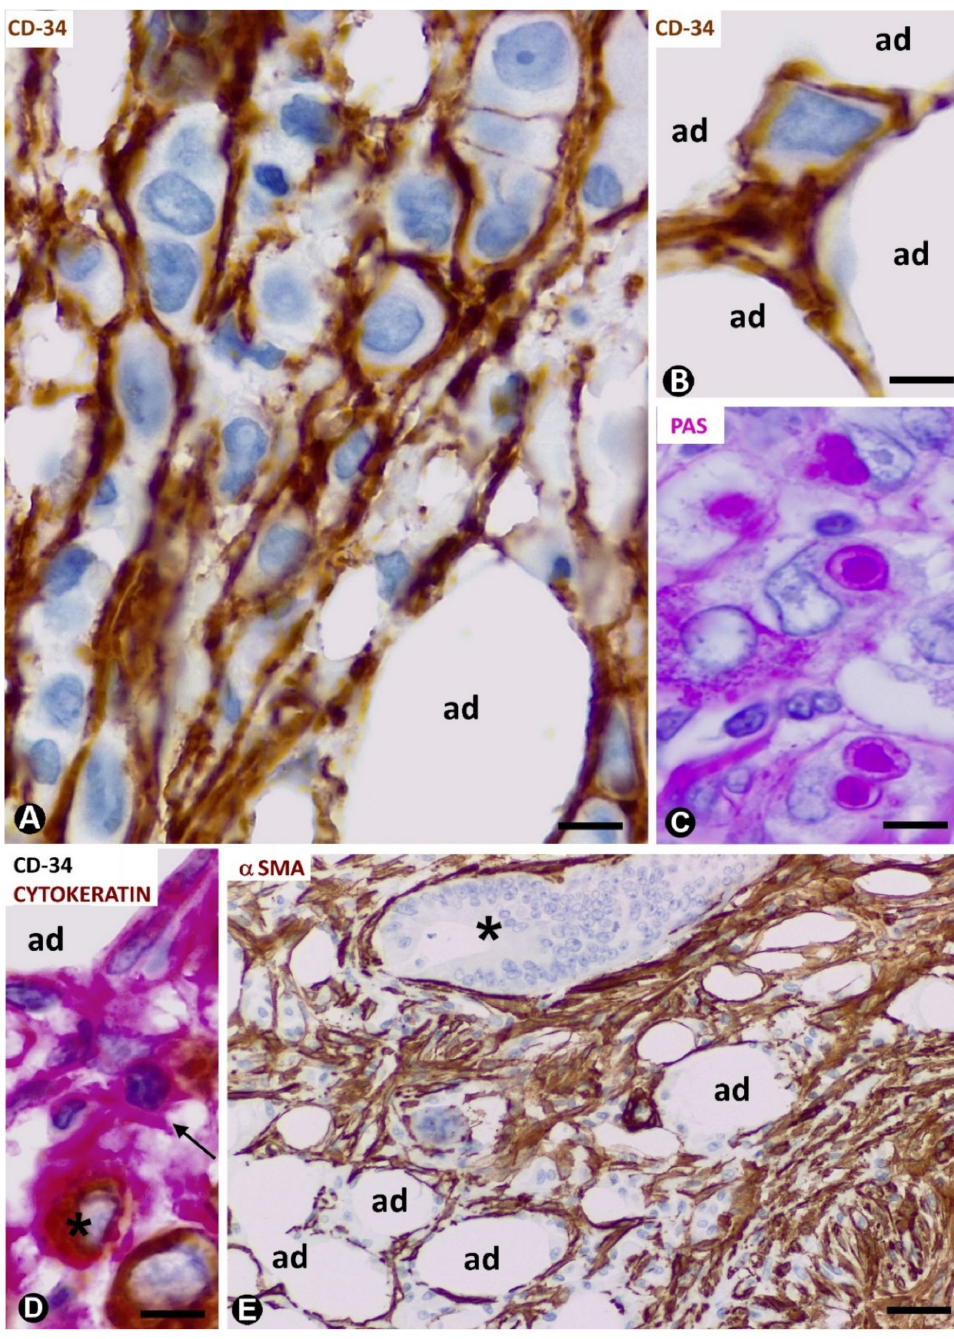
Figure 5. CD34 + and α SMA + stromal cells in tumours infiltrating adipose tissue. ( A – D ): signet ring carcinoma with Krukenberg tumour and peritoneal dissemination. TCs / CD34 + SCs are observed around neoplastic cells ( A , B , D ), which show PAS + vacuoles ( C ) and express cytokeratin AE1 / AE3 ( D ). ( A , B ): CD34 immunochemistry; haematoxylin counterstain. ( C ): PAS staining. ( D ): double immunochemistry labelling for CD34 (red) and cytokeratin AE1 / AE3 (brown). ( E ): neoplastic glands (asterisk) of adenocarcinoma of colon infiltrating adipose tissue. α SMA cells (brown) are observed in the stroma. α SMA immunochemistry. Haematoxylin counterstain. Bar: ( A – D ): 20 µ m; ( E ): 100 µ